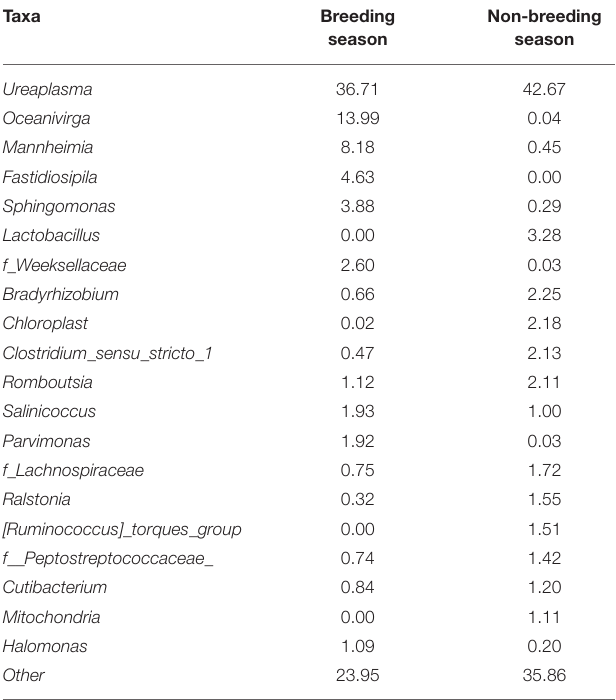
TABLE 2 | Mean relative abundance (%) of the taxa at the genus level (or the family level when the genus could not be assigned) in the goat buck ejaculates collected during the breeding and non-breeding